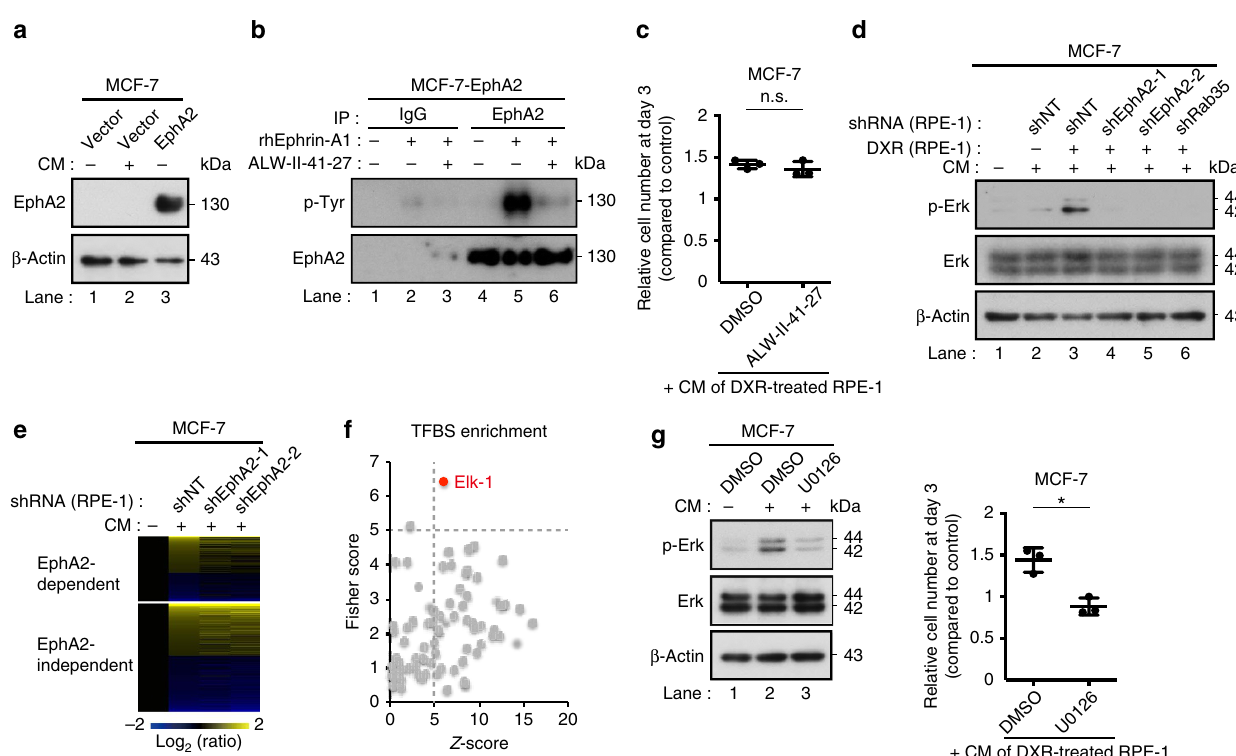
Figure 6 | sEV-associated EphA2 promotes cancer cell proliferation through EphA2/ephrin-A1 reverse signalling. ( a ) Immunoblotting of EphA2 and b -actin in the WCL of MCF-7 cells expressing empty vector or ectopic EphA2. Cells were grown for 3 days with or without CM prepared from DXR-induced senescent RPE-1 cells. ( b ) EphA2 immunoprecipitates prepared from MCF-7 cells expressing ectopic EphA2 were immunoblotted with anti- phosphotyrosine and anti-EphA2 antibody. The indicated samples were treated with recombinant human ephrin-A1 (500ngml (cid:3) 1 ) for 20min. Eight-hour pre-treatment with the EphA2 inhibitor ALW-II-41-27 (100nM) suppressed ephrin-A1-induced EphA2 phosphorylation. ( c ) Relative numbers of MCF-7 cells grown for 3 days in the presence of CM compared with the number of cells grown for 3 days in normal medium. DMSO or ALW-II-41-27 (100nM) was added to the medium. ( d ) Immunoblotting of phospho-Erk, total-Erk and b -actin in the WCL of MCF-7 cells grown for 3 days with or without